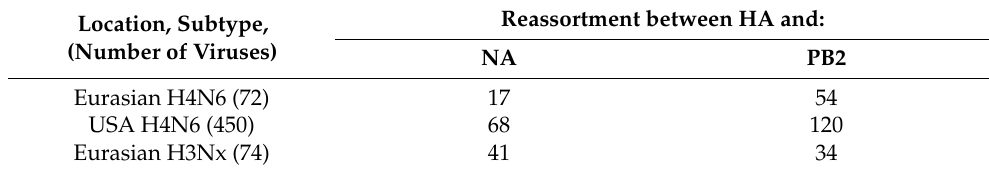
Reassortment between HA and: NA PB2